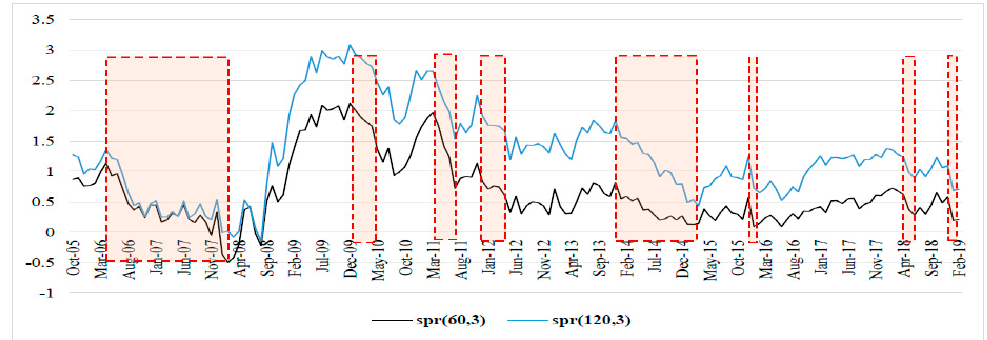
Figure 3. Yield spread-Germany.